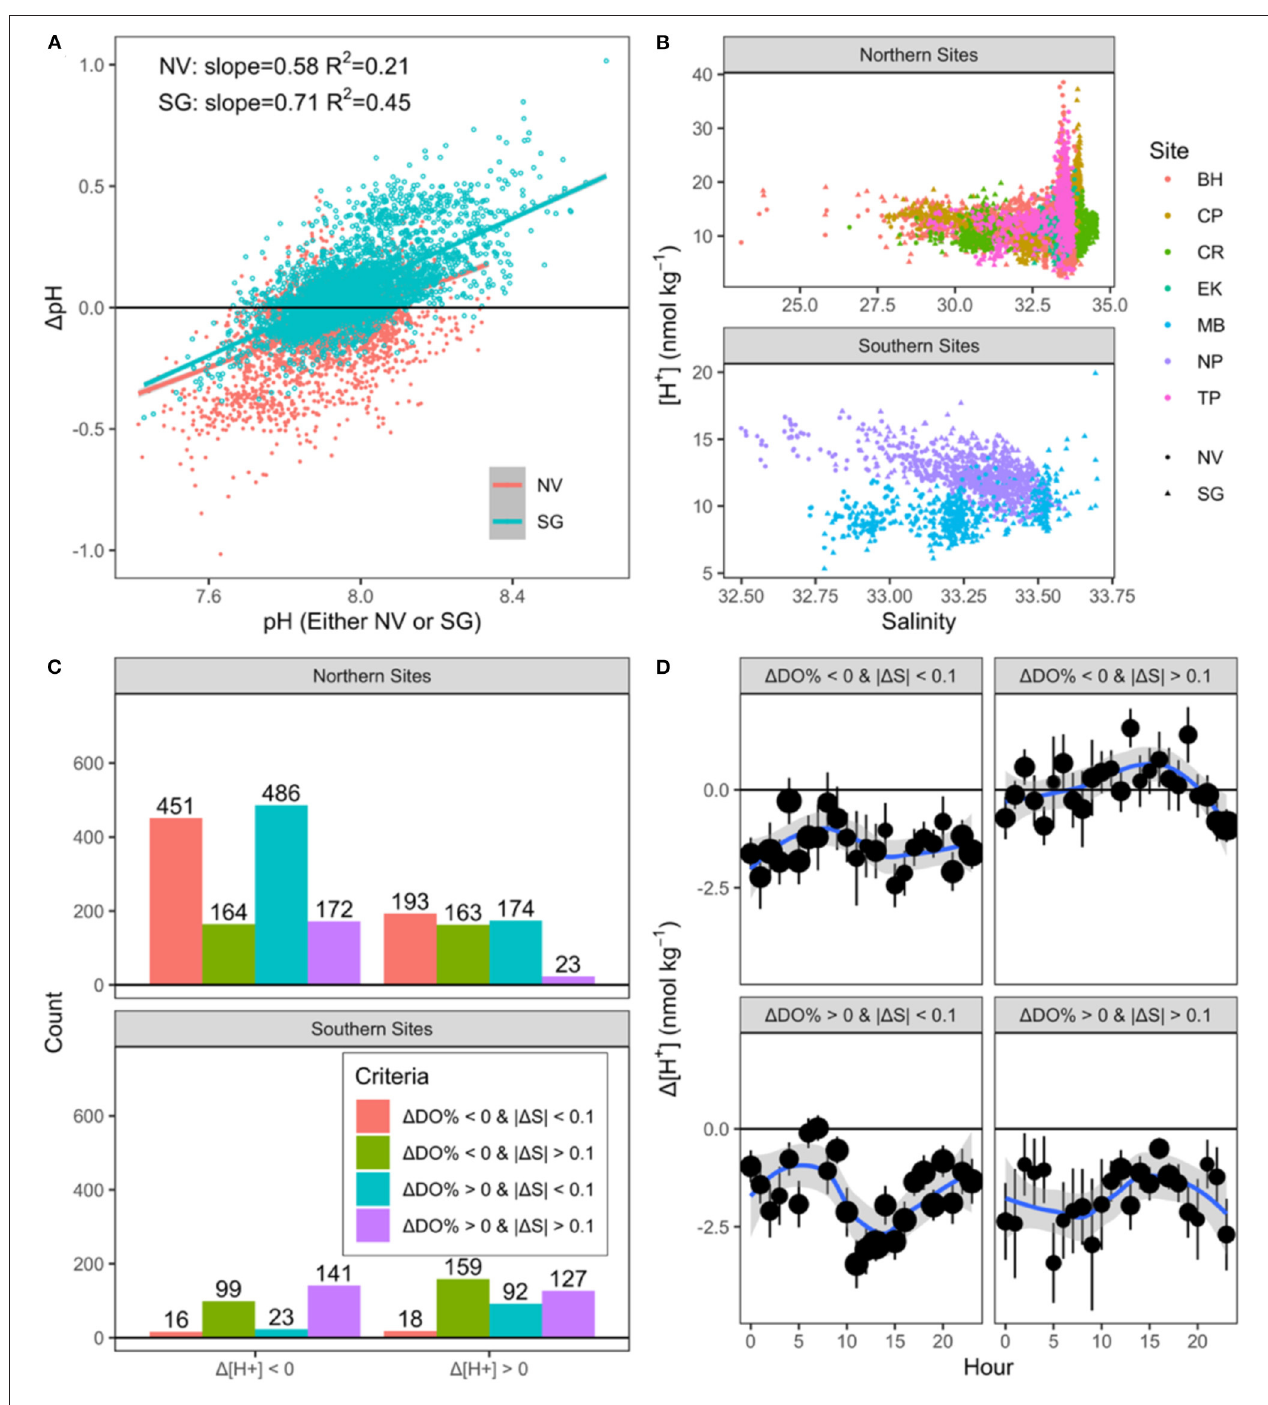
FIGURE 1 | Linear correlation ( p < 0.001) between pH and 1 pH (A) . Relationship between salinity and [H + ], separated by region and site (B) . Points in (B) are colored by site, while the shape identifies between “Seagrass” (SG) and “Non-vegetated” (NV) areas. Counts of positive and negative 1 [H + ] hourly averages, separated by region and by the threshold criteria described in the legend (C) . Hourly climatology (D) of 1 [H + ], separated by the same criteria as (C) , with point size scaled to represent sample